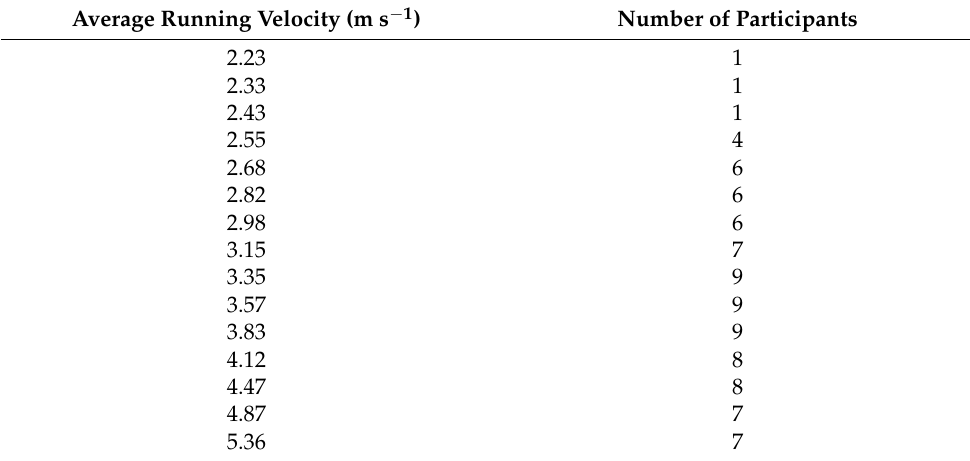
Table 1. Distribution of average running speeds.